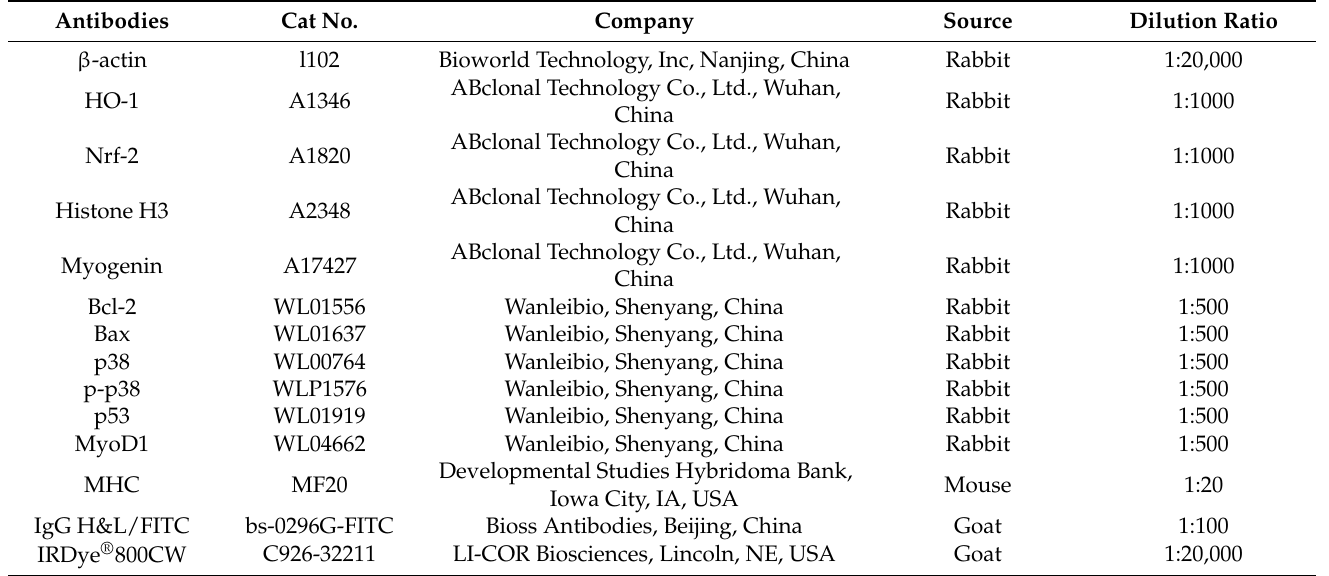
Table 1. Antibodies